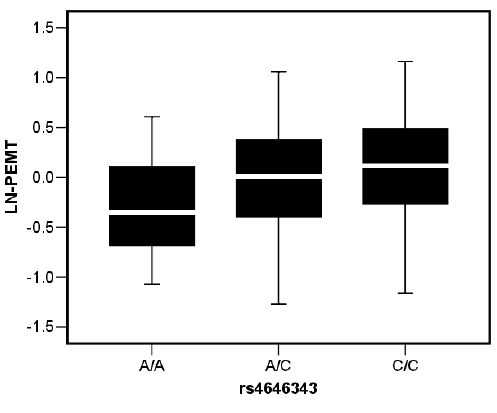
Figure 1. Genotypic association of SNP rs4646343 with PEMT expression in subcutaneous adipose. The box plot shows transcript level expression of PEMT for different genotypes (AA, n=26; AC, n=59 and CC, n=69). PEMT expression is shown after 36B4 normalization and ln transformation. The box represents the interquartile range, which contains 50% of the values. The whiskers are lines that extend the box to the highest and lowest values, excluding outliers. A line across the box indicates the median.